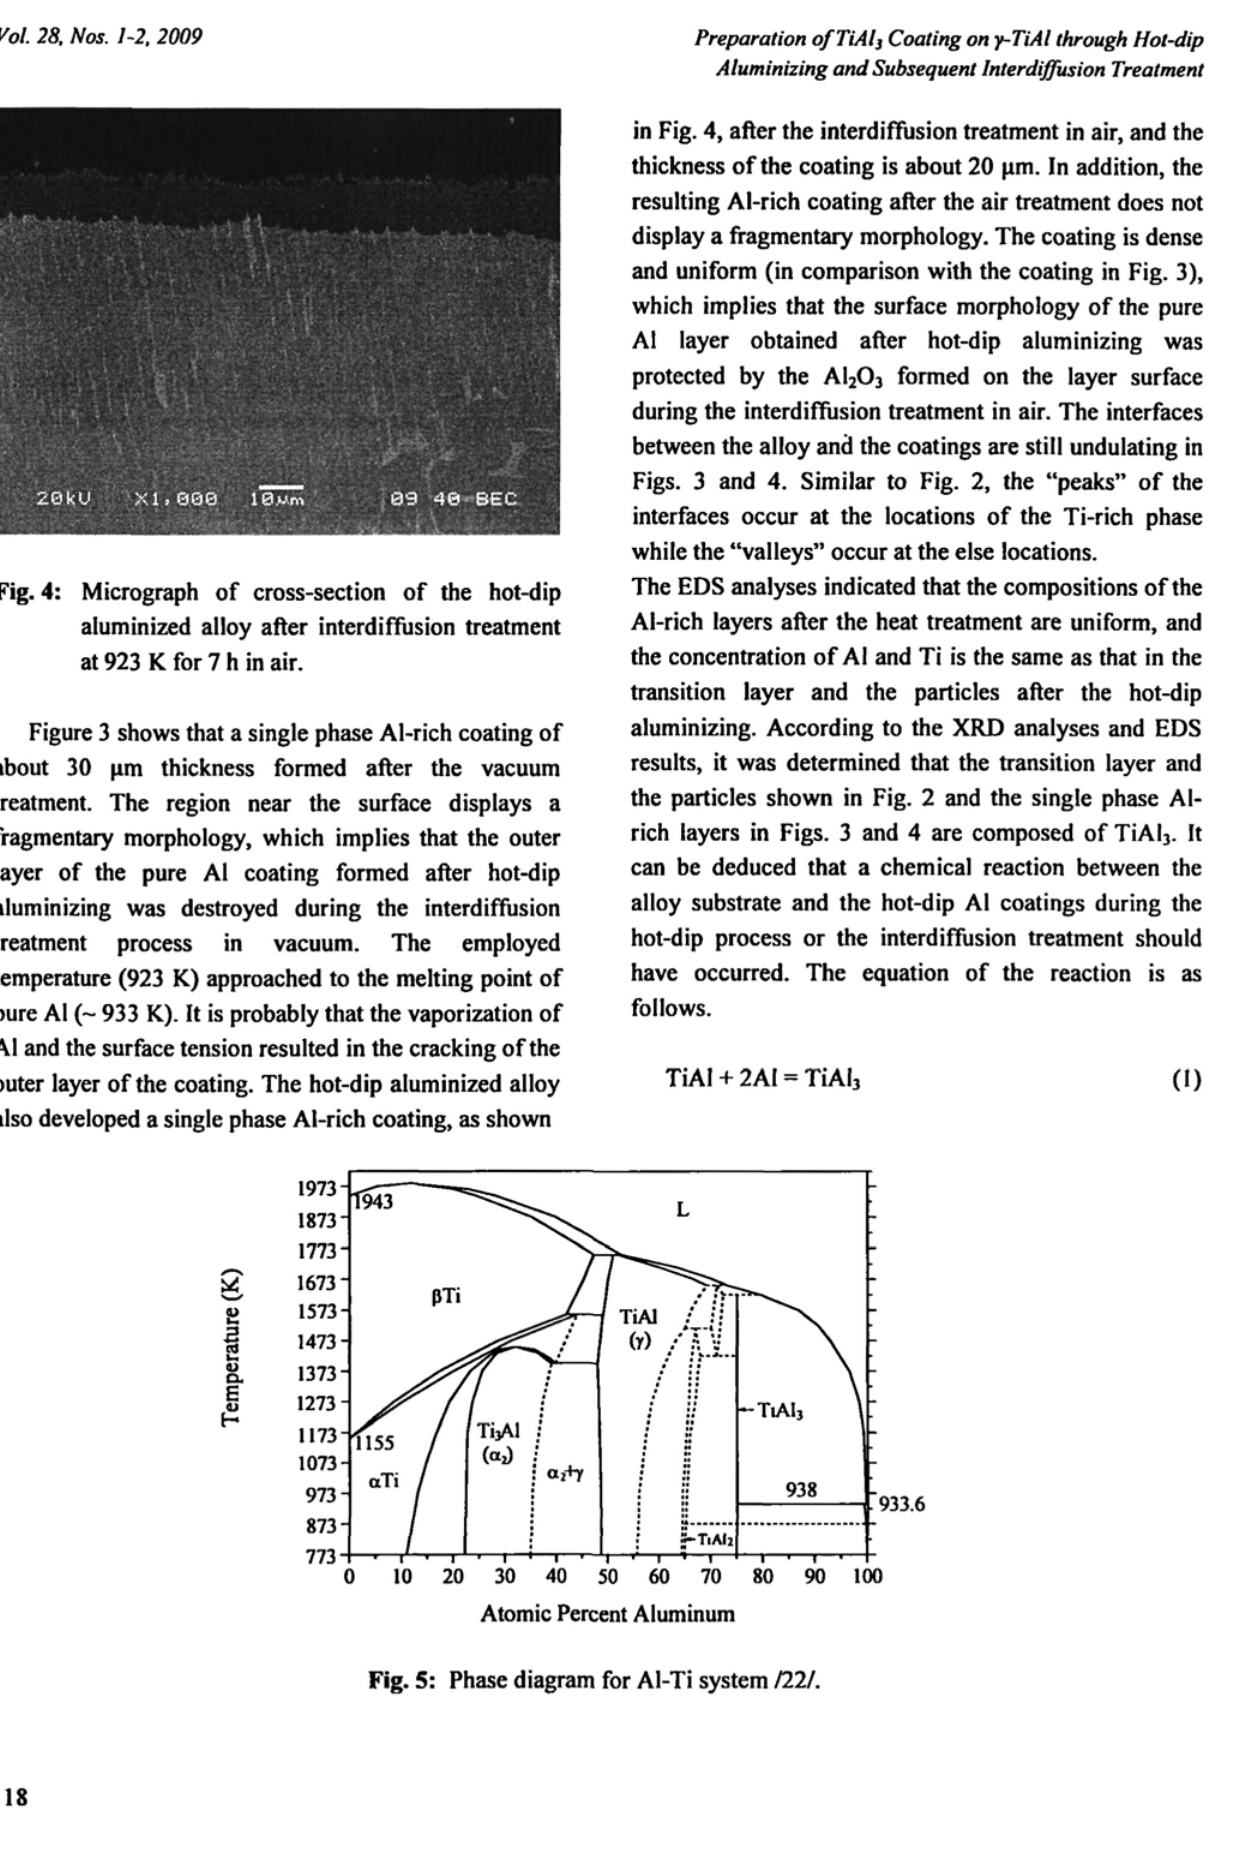
Fig. 5: Phase diagram for Al-Ti system